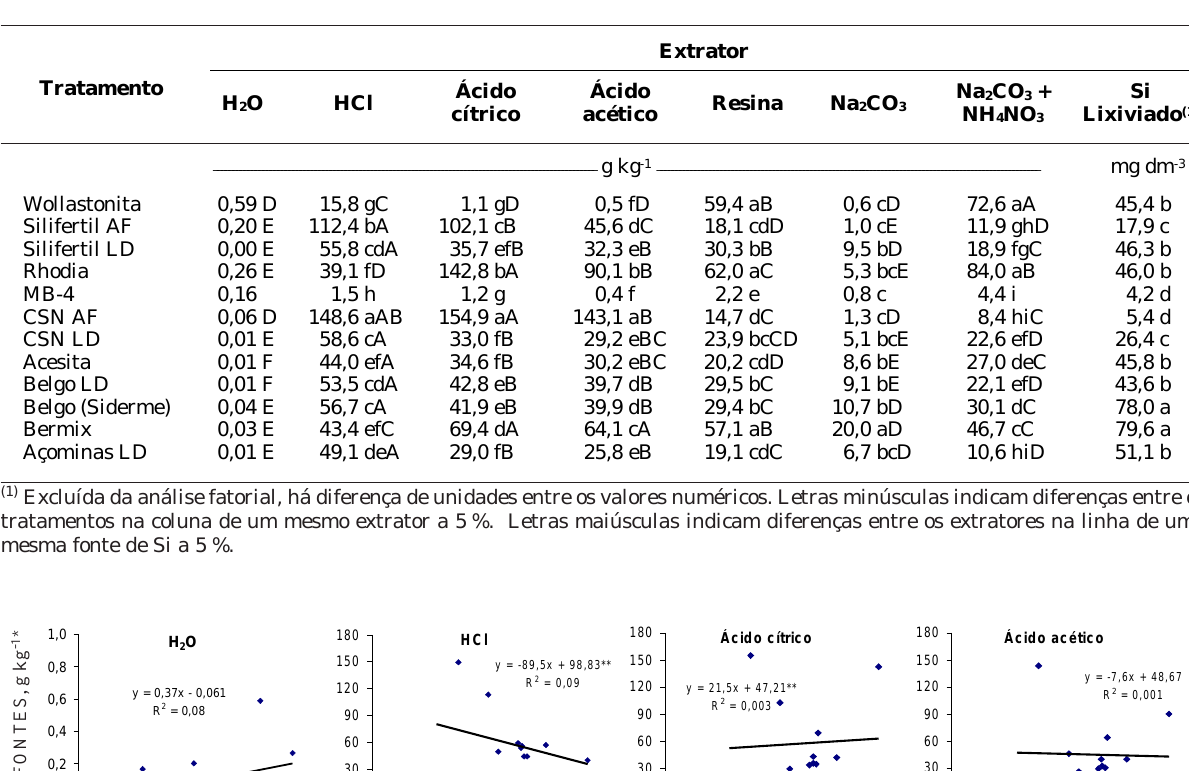
Quadro 6. Teores de Si extraídos das fontes pelos diversos extratores